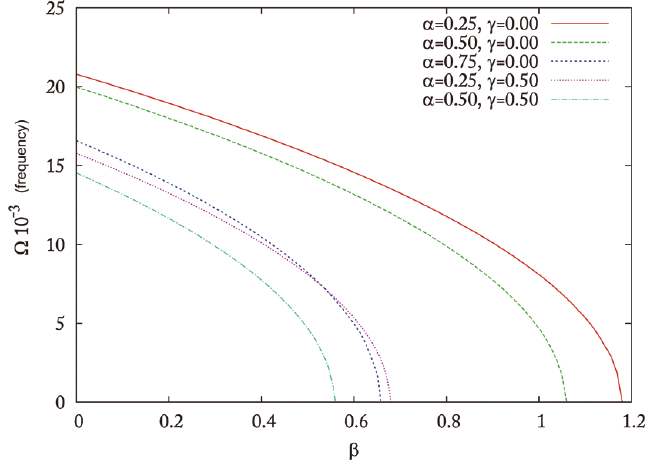
Fig. 10. PLATE-11, LD1, a/h = 30, a = b, SSSS.